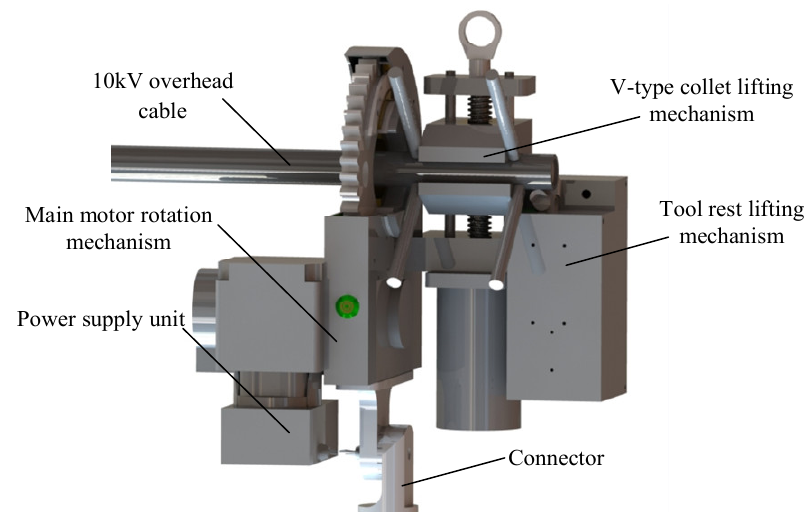
Figure 2. Structure of the cable-stripping robot.